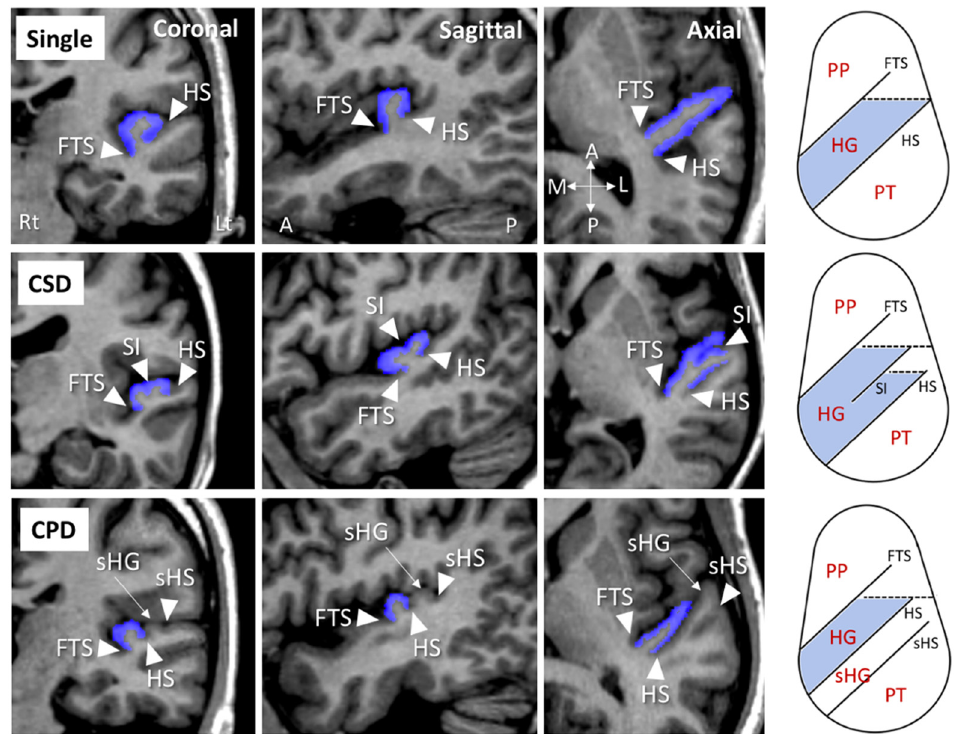
Figure 1. Coronal, sagittal, and axial views of sample MRI of Heschl’s gyrus (HG; colored in blue) and schematic drawings of the superior temporal surface on an axial view (right) of different gyrification patterns. A, anterior; CPD, complete posterior duplication; CSD, common stem duplication; FTS, first transverse sulcus; HS, Heschl’s sulcus; L, lateral; P, posterior; M, medial; PT, planum temporale; PP, planum polare; sHG, second Heschl’s gyrus; sHS, second Heschl’s sulcus; SI, sulcus